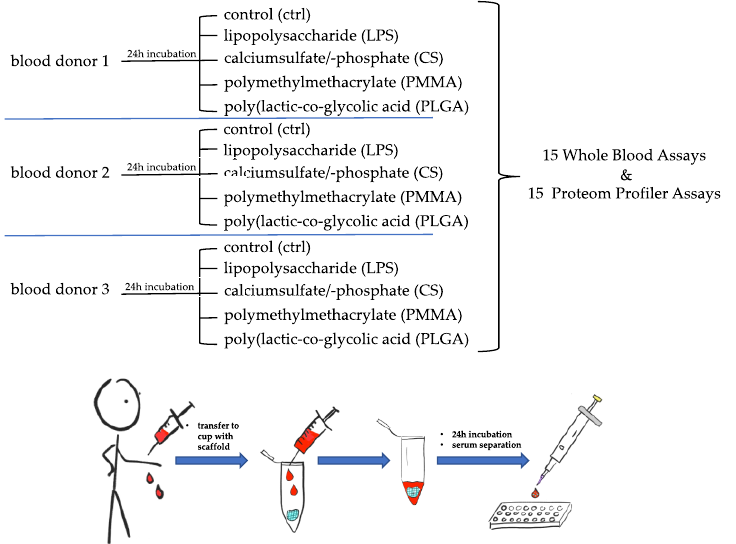
Figure 1. Schematic sequence of the experiments. Heparinized blood samples were not pooled. Scaf- folds were presented in medium (DMEM) and blood was added in a 3:1 ratio (medium/blood).